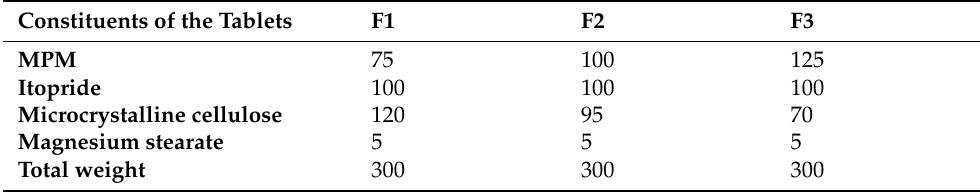
Table 1. Composition of MPM-based oral tablet formulations in mg/tablet. Constituents of the Tablets F1 MPM Itopride Microcrystalline